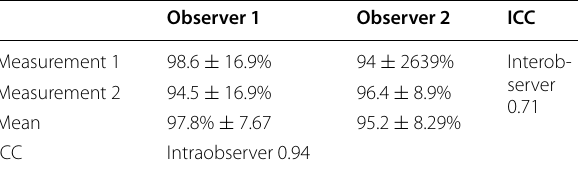
Table 1 Coverage ratio following first and second measurement in both assessors